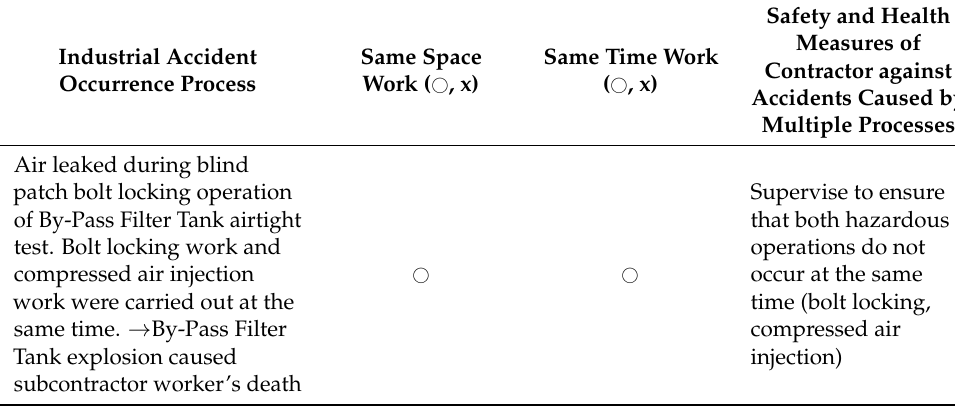
Table 5. Examples of fire and explosion accidents by multiple processes in the